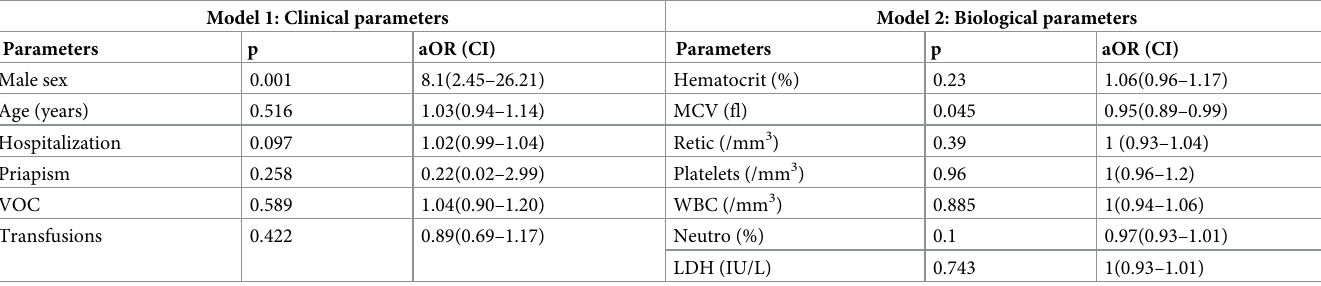
Table 5. Factors associated with leg